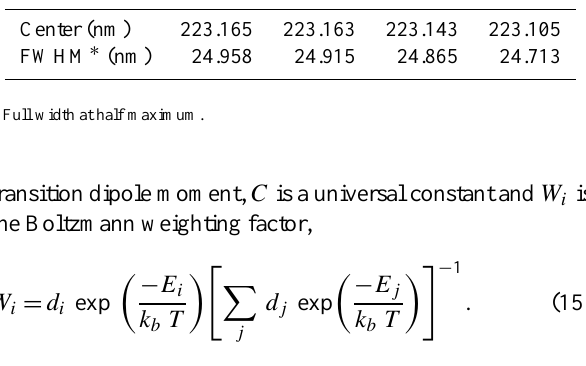
(Fig. 4). In contrast, 13 ε on the higher energy side was lower rowing is dominant in this region (Fig.